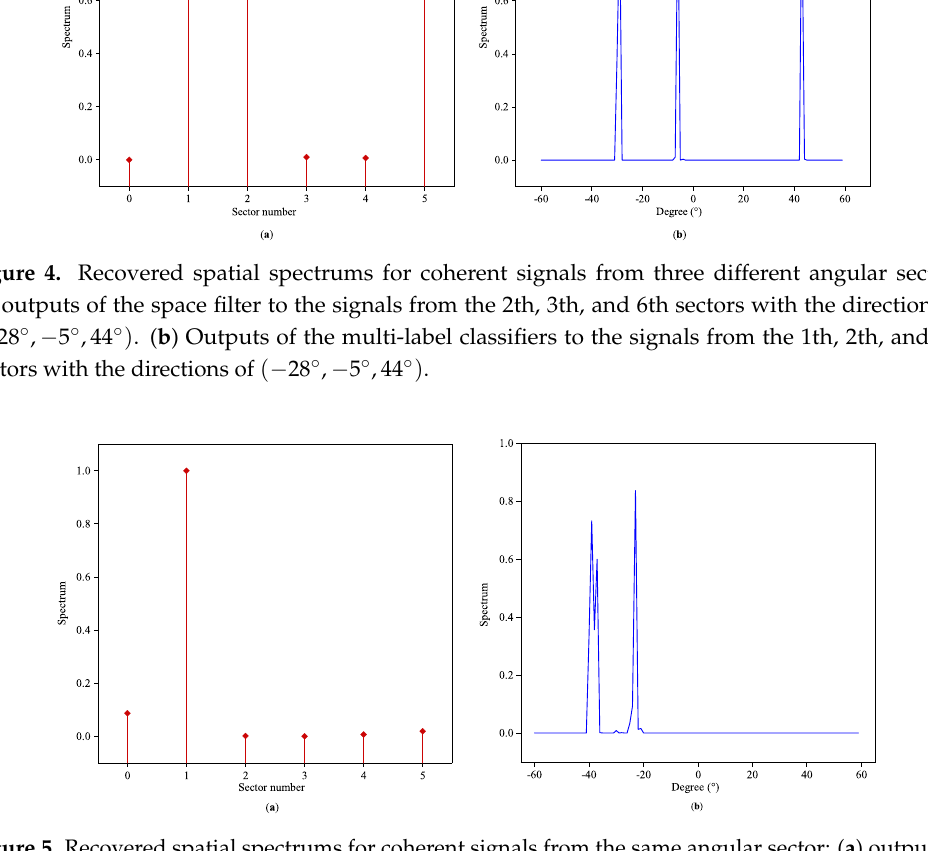
Figure 5. Recovered spatial spectrums for coherent signals from the same angular sector: ( a ) outputs of the space filter to the signals from the 2th sector with the directions of ( − 38 ◦ , − 36 ◦ , − 22 ◦ ) . ( b ) Outputs of the multi-label classifiers to the signals from the 2th sector with the directions of ( − 38 ◦ , − 36 ◦ , − 22 ◦ )